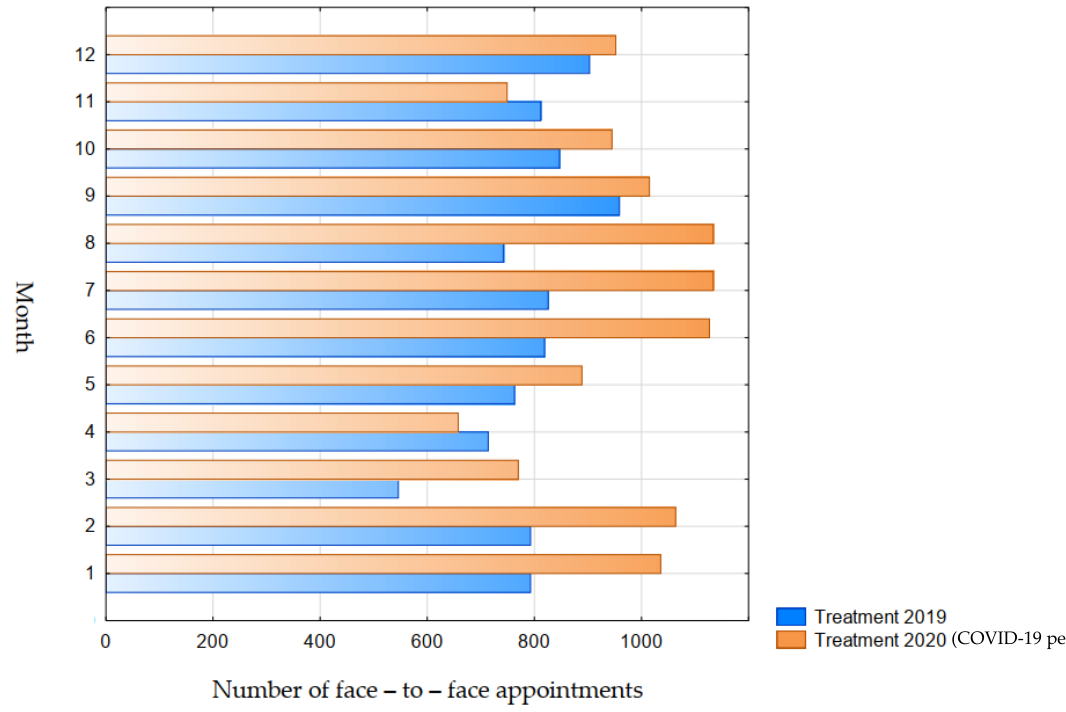
Figure 2. Change in the number of face-to-face appointments during the pandemic period from the prepandemic period.